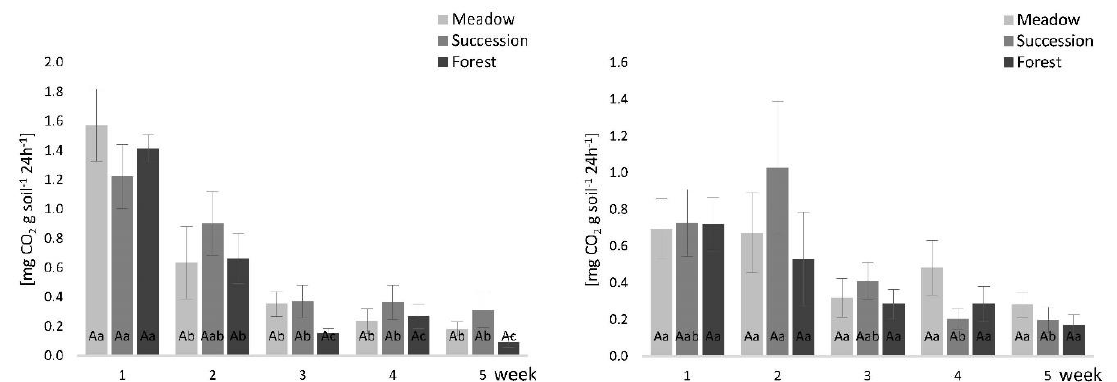
Figure 4. Soil respiration results for the ( a ) 0 – 10 cm and the ( b ) 10 – 20 cm soil layers. The lowercase letters indicate differences between individual weeks in the same land-use variants, while uppercase letters show differences between land-use variants for individual weeks (Tukey post hoc test, p < 0.05). Standard error is reported as bars. Table 2. Mean and standard error values of cumulative value of mineralized carbon during incu- baTable 35 days (C m ), potentially mineralizable carbon (C 0 ) and rate constant (k) results. The lower- case letters indicate differences between examined soil layers for individual land-use variants, while uppercase letters show differences between land-use variants separately for the 0 – 10 and 10 – 20 cm soil layers (Tukey post hoc test, p < 0 .05). Standard error is reported behind “±”.